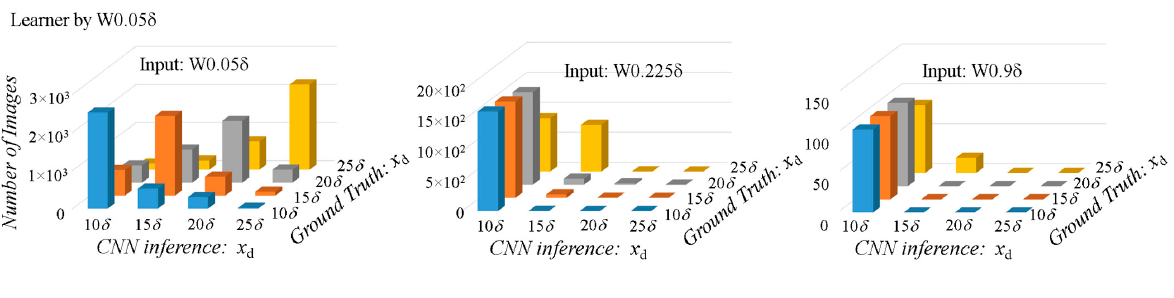
Figure 8. Sample images of W0.9 δ and zoomed-up W0.05 δ with the same image size.